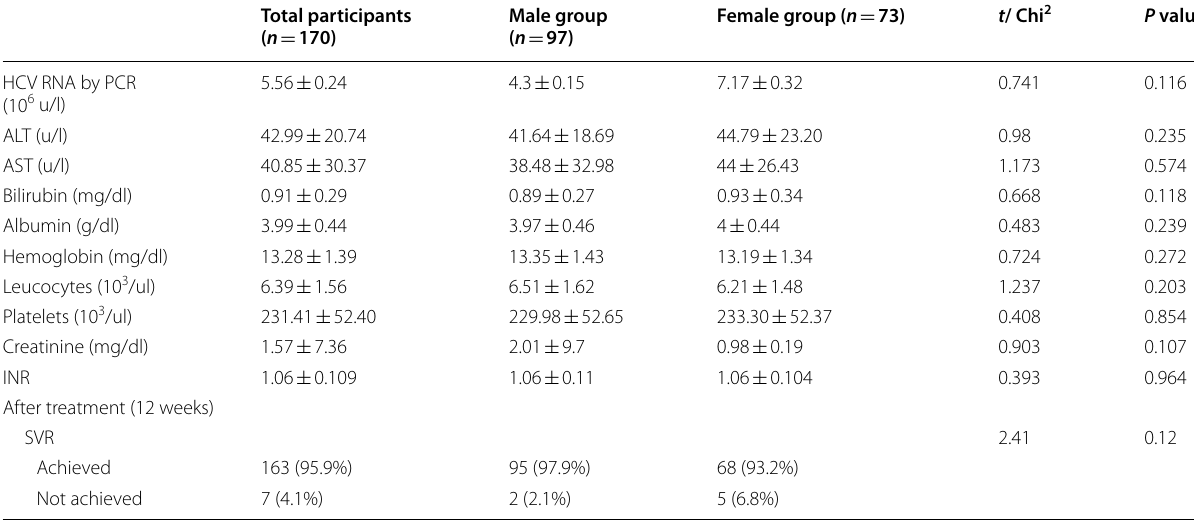
Data expressed as frequency (percentage), mean (SD). HCV RNA hepatitis C virus ribonucleic acid, PCR the polymerase chain reaction, ALT alanine transaminase, AST aspartate transaminase, INR international randomized ratio, SVR Sustained virological